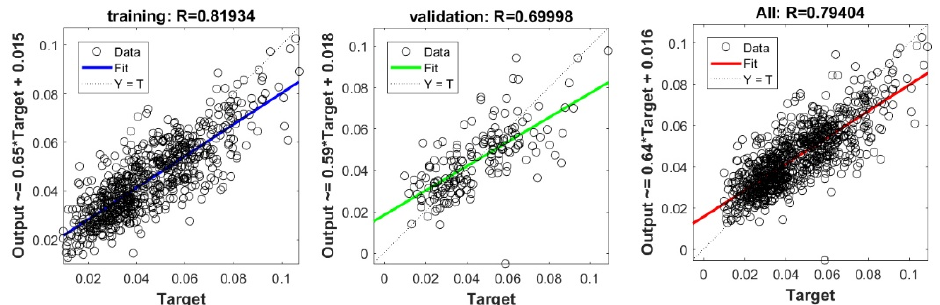
Figure A2. Scatter plots between target and output value by the FS-DNN model.